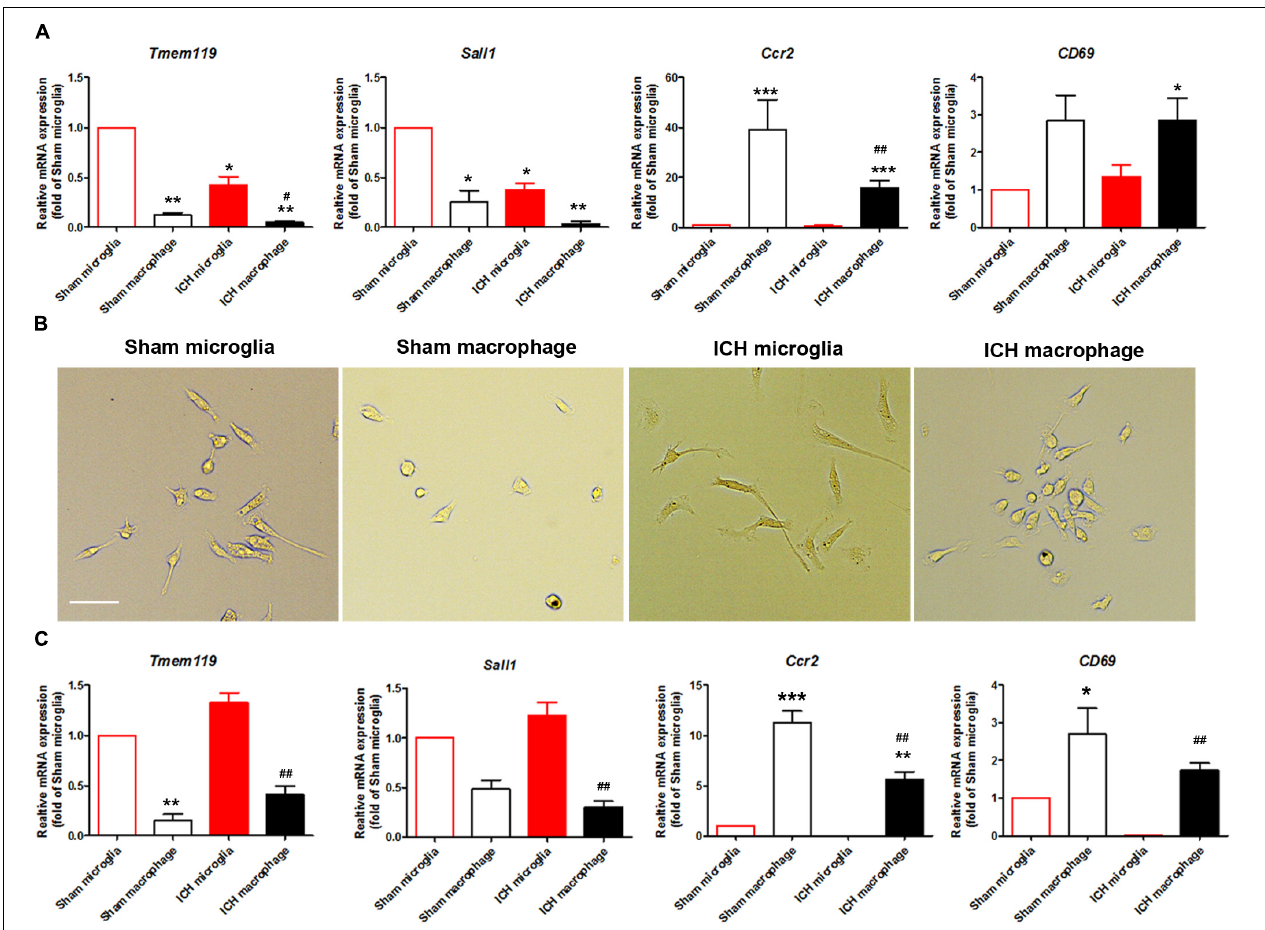
FIGURE 5 | Expression of microglia- and monocyte/macrophage-specific markers in sorted and cultured cells after ICH. Eight- to ten-week-old male C57BL/6 mice underwent collagenase injection or sham procedure. Mice were sacrificed at day 1 post-ICH. Mouse brain was perfused with phosphate-buffered saline and dissociated into single cells. Microglia (Ly6g − CD11b + CD45 Int PI − ) and monocytes/macrophages (Ly6g − CD11b + CD45 high PI − ) were isolated and sorted. (A) mRNA from cells was extracted and real-time PCR carried out with different primers. GAPDH was used as an internal control, and results are shown as fold of control. (B) Sorted cells were seeded and bright field images were taken after 3 days in culture. Representative images are shown. (C) mRNA was extracted after sorted cells were cultured for 3 days. Real-time PCR was carried out with different primers. GAPDH was used as an internal control, and results are shown as fold of sham microglia. ∗ p < 0.05, ∗∗ p < 0.01, ∗∗∗ p < 0.001 vs. corresponding control; # p < 0.05, ## p < 0.01 vs. corresponding group in sham animals; n = 3. Results are presented as mean ± SD. One-way ANOVA followed by Dunn’s multiple comparison post-test. Scale bars: (B) 20 µ